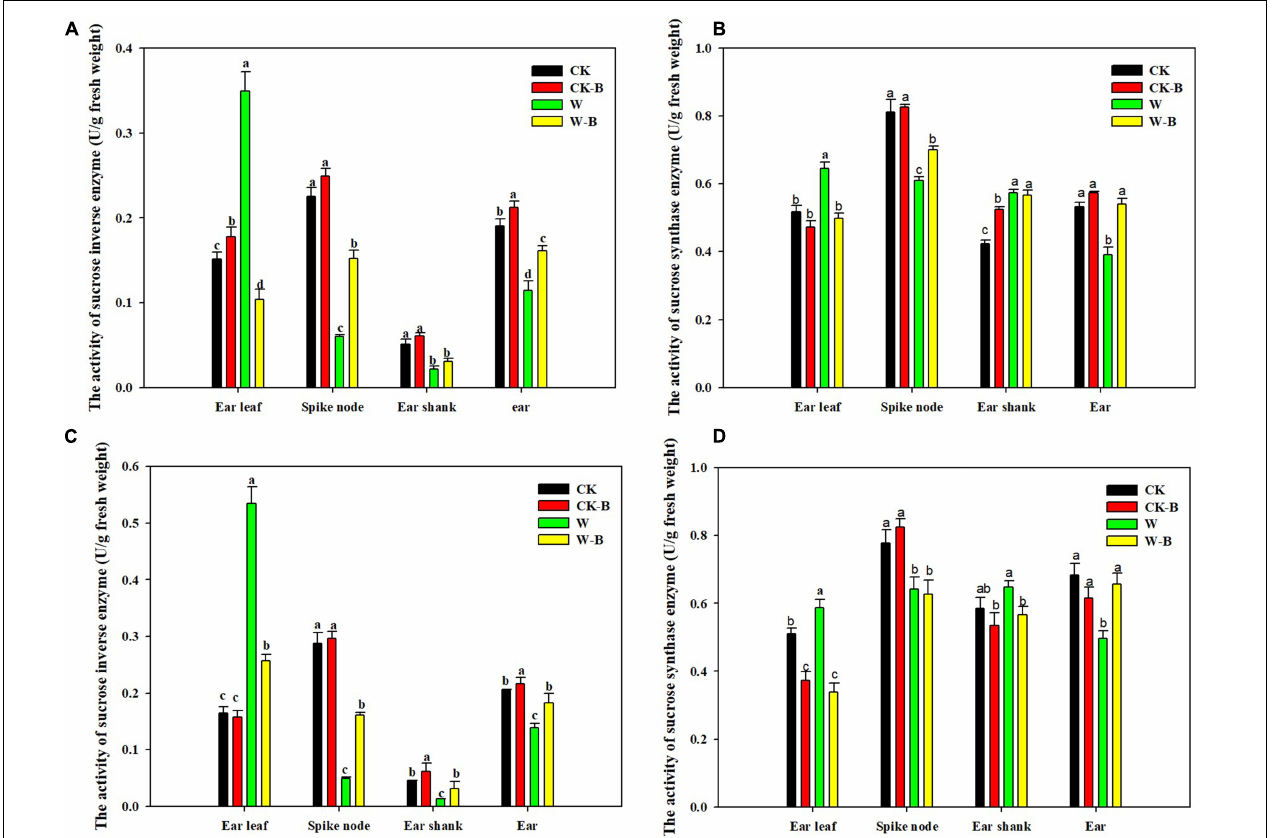
FIGURE 6 | The effects of 6-BA on the activities of sucrose-cleaving enzymes at T2 stage. (A) (2017), (C) (2018), The activities of sucrose invertase enzyme in 2017 and 2018; (B) (2017), (D) (2018), The activities of sucrose synthase enzyme in 2017 and 2018. CK, control, no waterlogging stress; CK-B, spraying 6-BA on non-waterlogged plants; W, waterlogging; W-B, spraying 6-BA after waterlogging. Different letters on bars indicate the significant differences among treatments at P < 0.05 using the LSD